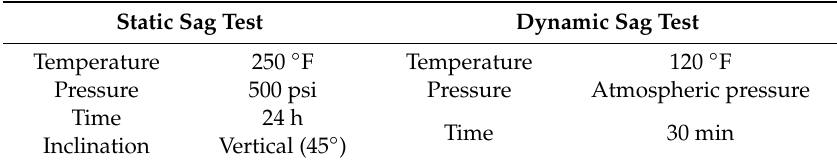
Figure 3. Static sag test set-up [28]. Table 3. Experimental conditions for sag test.